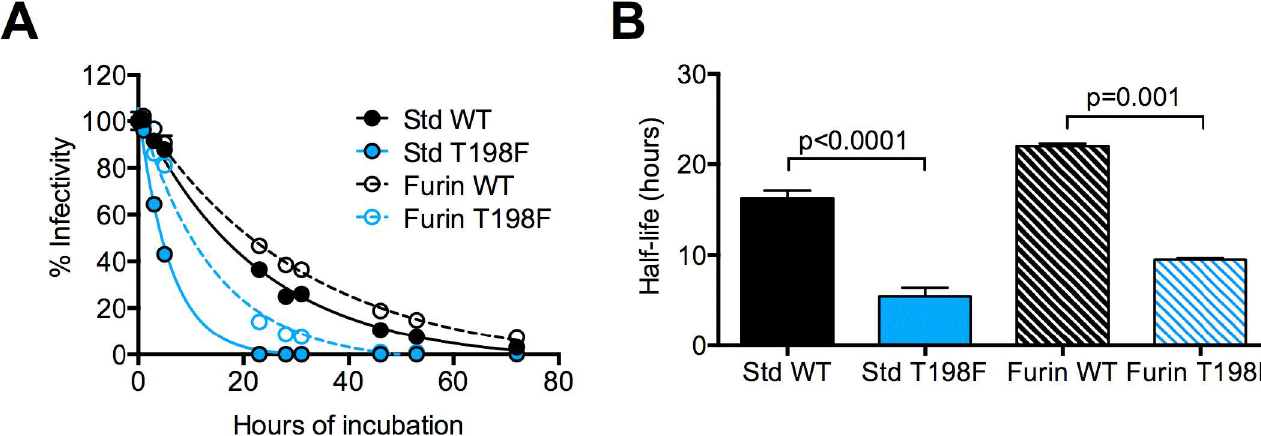
Fig 4. Stability of WNV E T198F RVPs. (A) Intrinsic decay of the infectivity of WT and T198F RVPs. Standardor Furin RVP preparations were equilibratedat 37˚C for 1 h and further incubatedfor additionallengthsof time as indicatedon the x-axis, after which aliquots were harvestedand frozen. Samples from each time point were thawed concurrently and used to infect Raji-DC-SIGN-R cells. Data were normalizedto the infectivity of RVPs incubatedat 37˚C for 1 h and fitted to a one-phase exponential decay curve. Representative decay curves for WT and T198F RVPs are shown. Error bars indicatethe SEM from triplicate infections. (B) Paired t-tests were used to compare the half-life of infectivity of WT and T198F RVPs. Shown are mean half-life values obtained from three independent experiments performed in triplicate. Error bars represent the SEM.